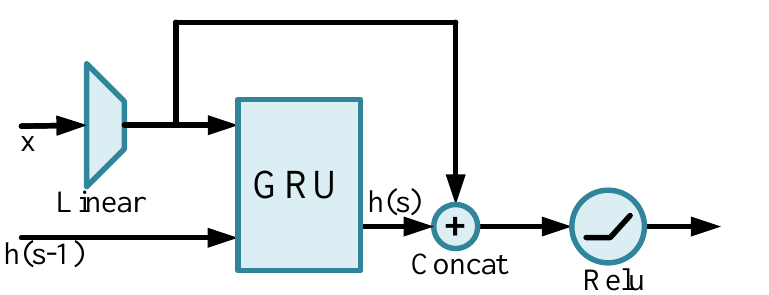
Figure 4. Temporal memory block consists of a GRU branch and a linear branch.